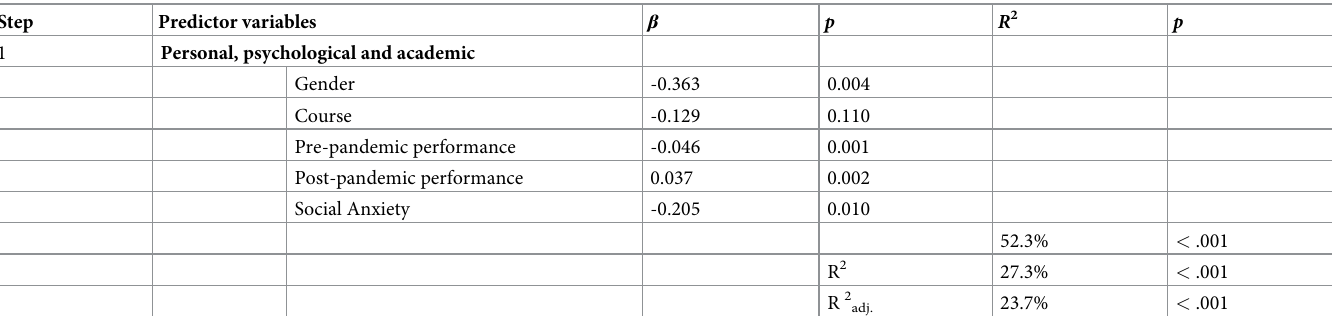
Table 2. Linear regression for improvement or worsening of academic performance during the pandemic.